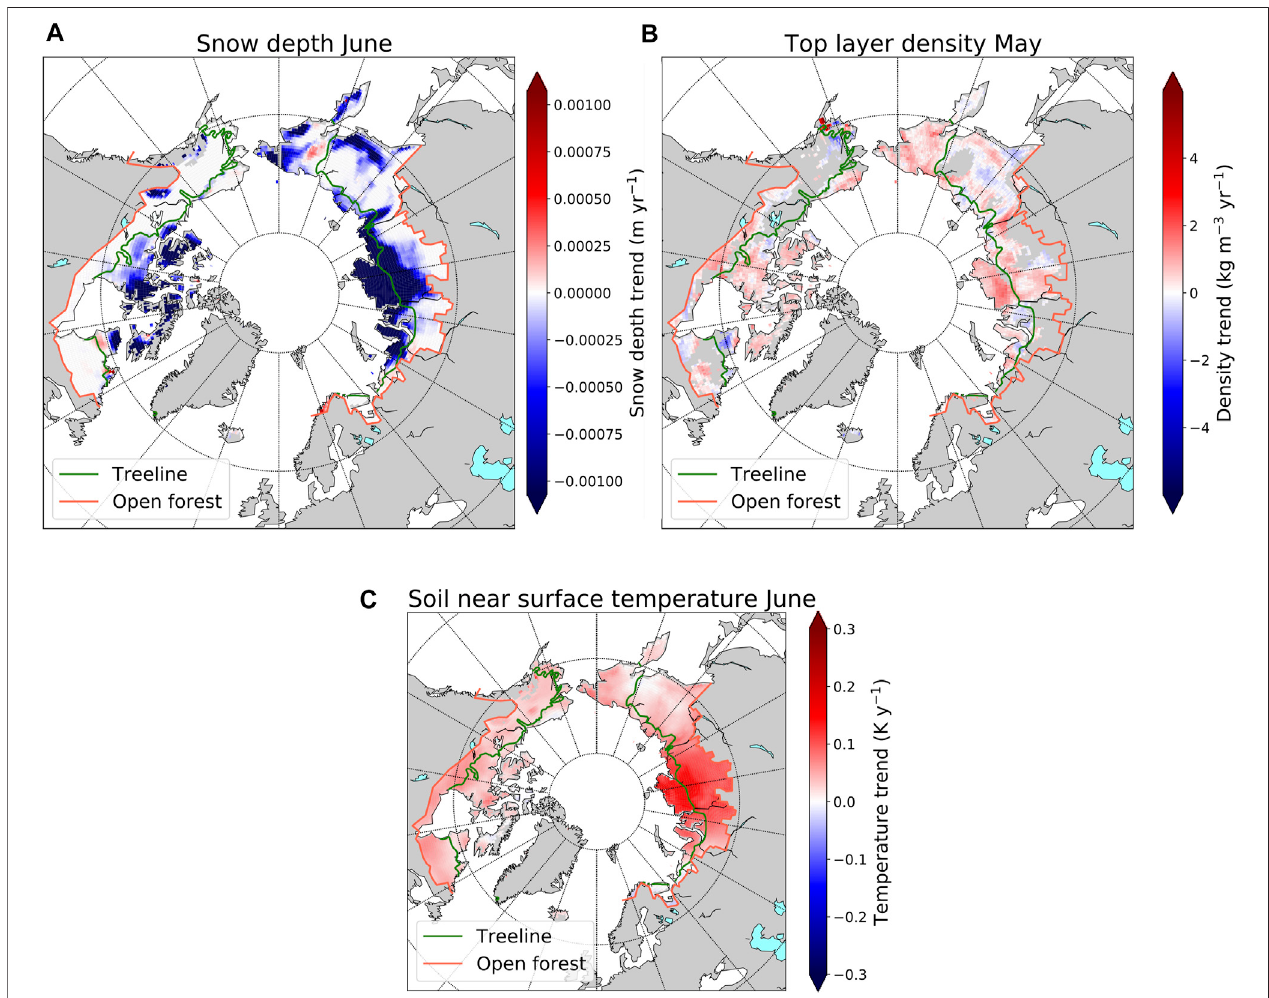
FIGURE 7 | Spatial distribution of trends between 1979 and 2018 of snow depth in June (A) , top layer density in May (B) , and soil near surface temperature in June (C) .